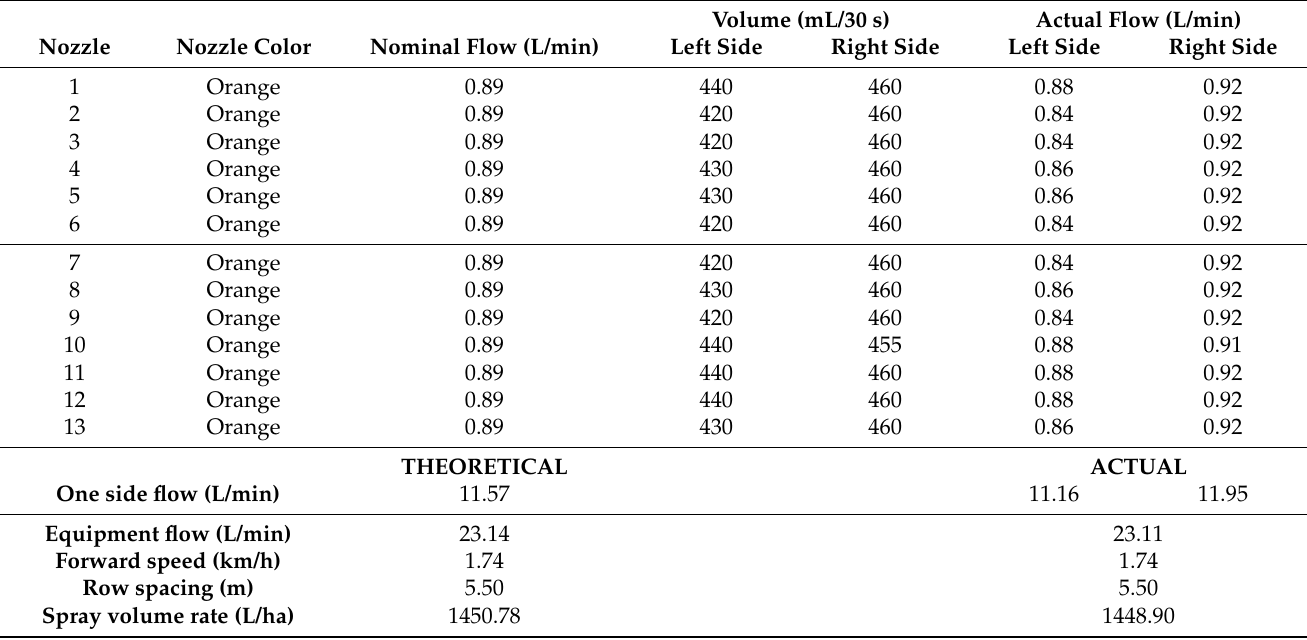
Table A14. Selection and calibration of nozzles for the C2 sprayer, with the following configuration: No adjusted to the vegetation/High & Low fan speed/Low spray volume rate/Drift-reducing nozzles (Coarse)/Pressure: 15